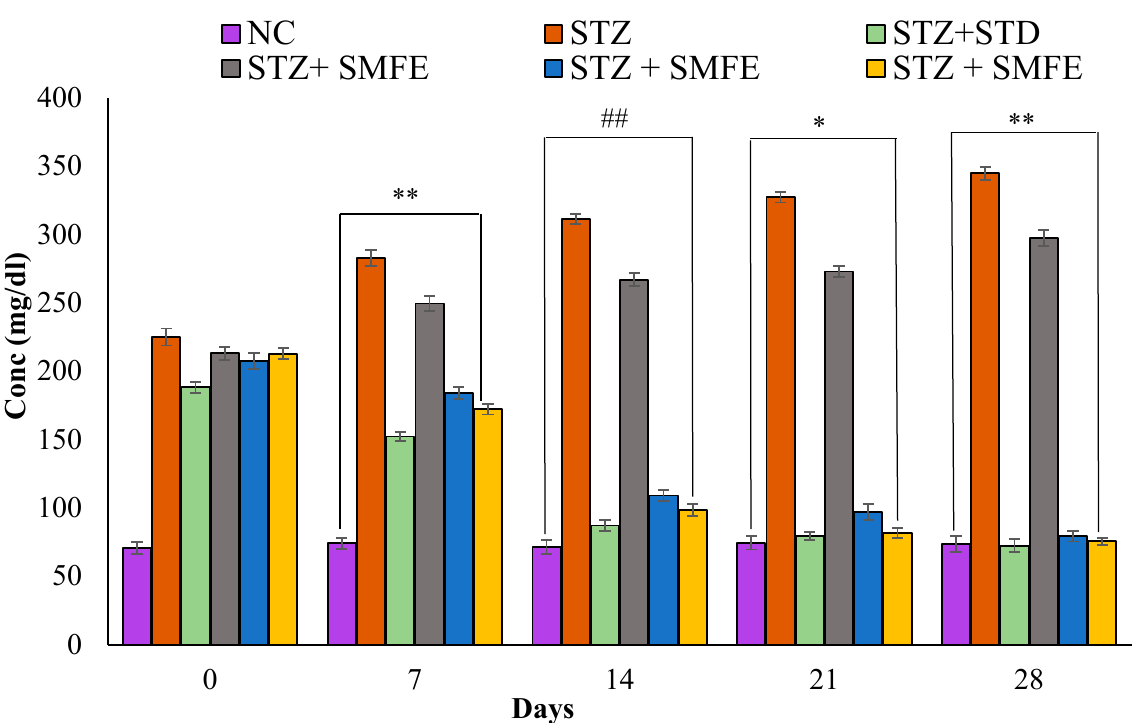
Figure 6. Analyzing the effects of SMF extract and glibenclamide on weekly blood glucose levels in both non-diabetic and STZ-induced diabetic mice. Data are represented as the mean ± SEM ( n = 6). ** p < 0.01 = significant when compared with diabetic control. * p < 0.05 and ## p < 0.01 = significant when compared with diabetic control. NC = normal control; STZ = streptozotocin; SMFE = S. mangifera fruit extract; STD = standard drug (Glibenclamide).